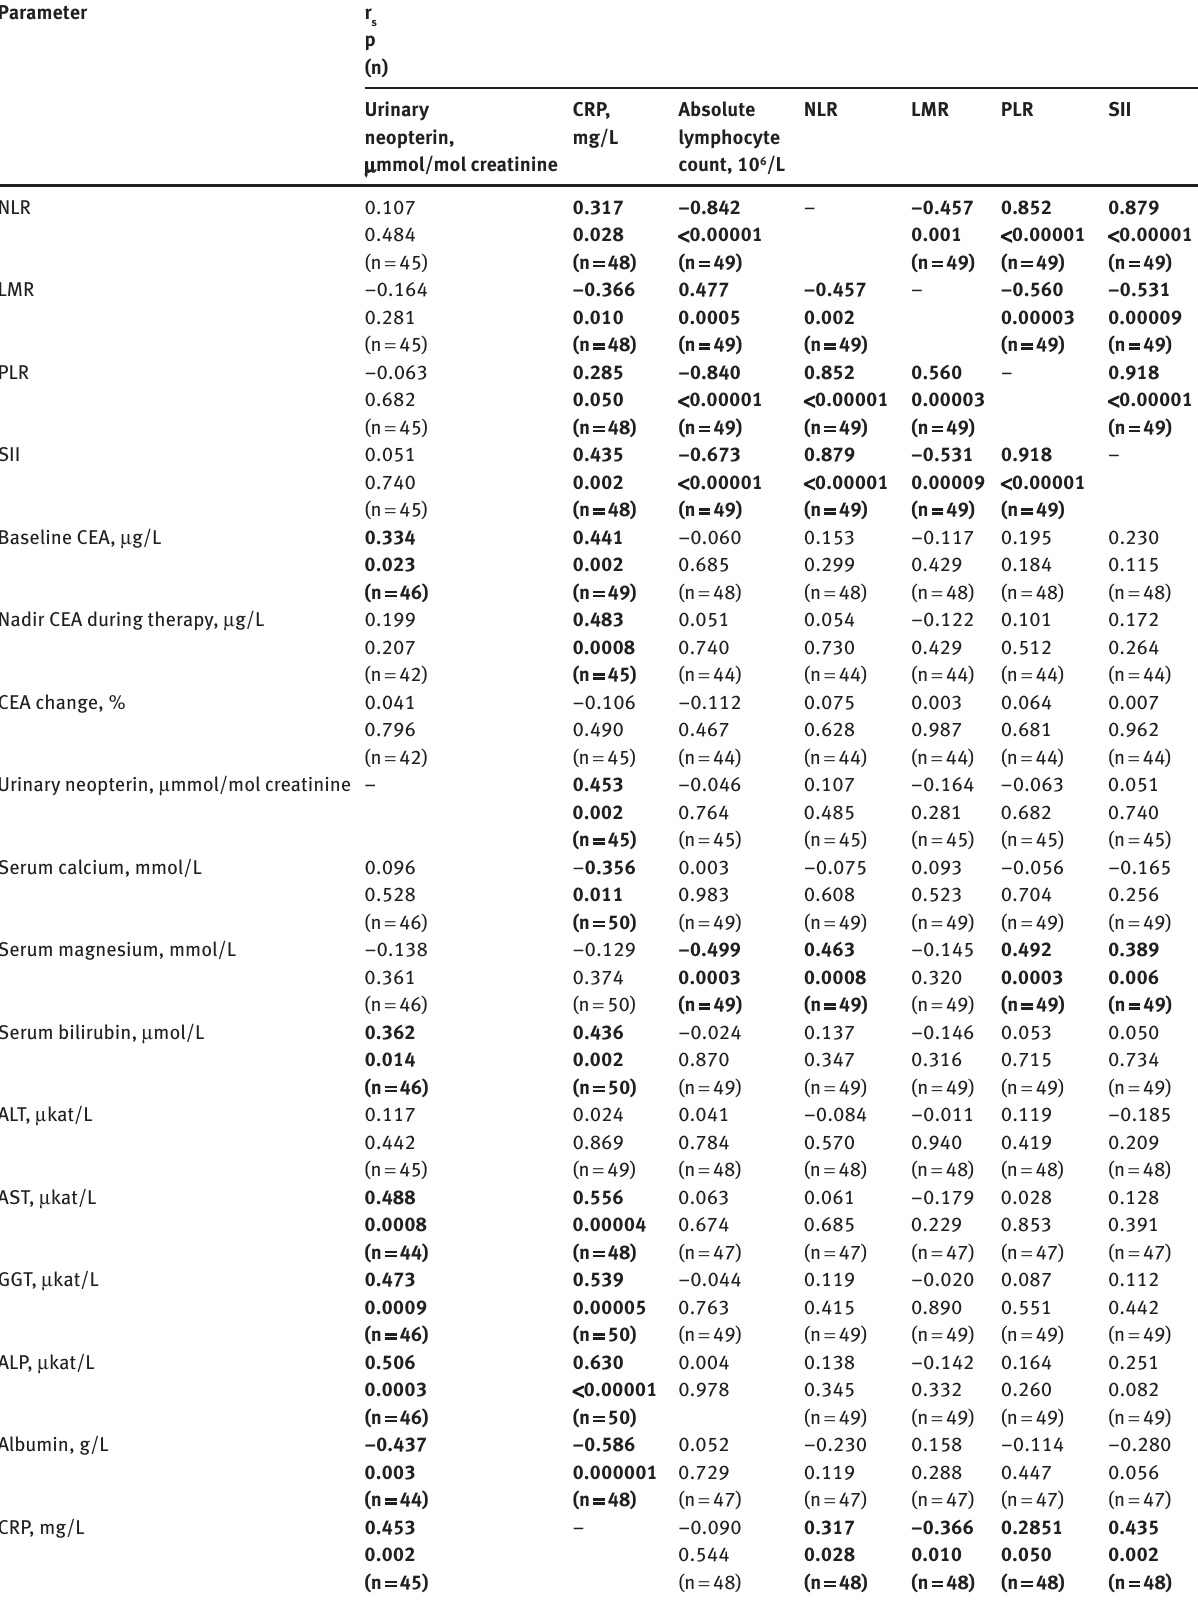
Table 2: Correlation between urinary neopterin, serum CRP, PBC-derived ratios and other laboratory parameters.